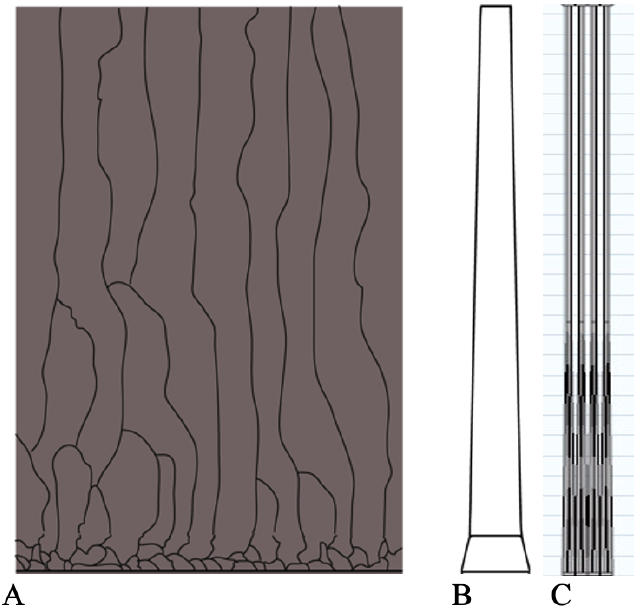
Figure 5. Theoretical grain morphology ( A ) compared to two geometrical models ( B , C